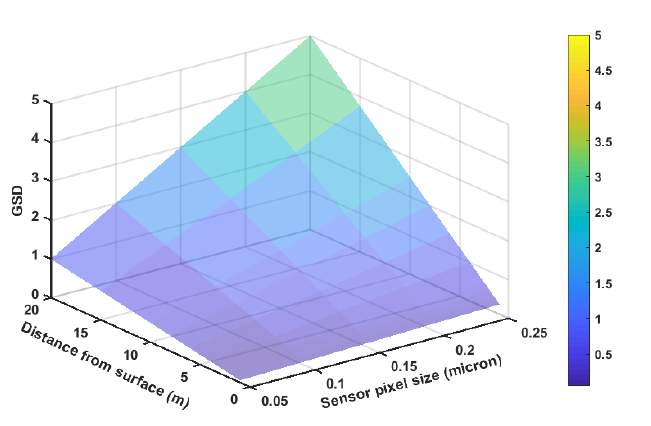
Figure 5. Simulated ground sample distance (GSD) for various sensors’ pixel size and surface